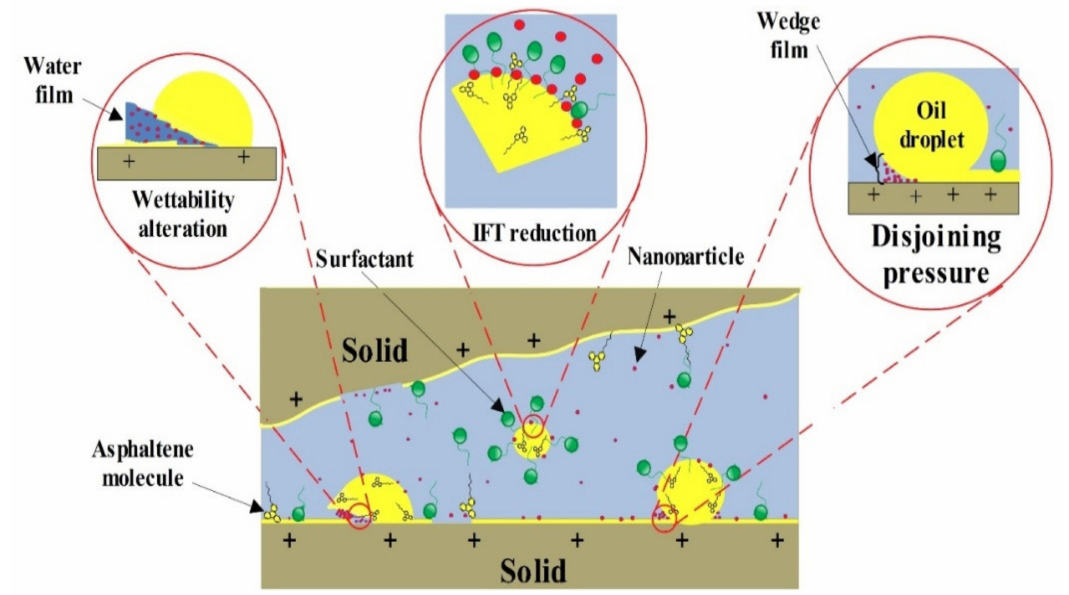
Figure 14. Schematic view of surface interactions of the carbonate rock–oil–aqueous phase (containing surfactant + NPs)